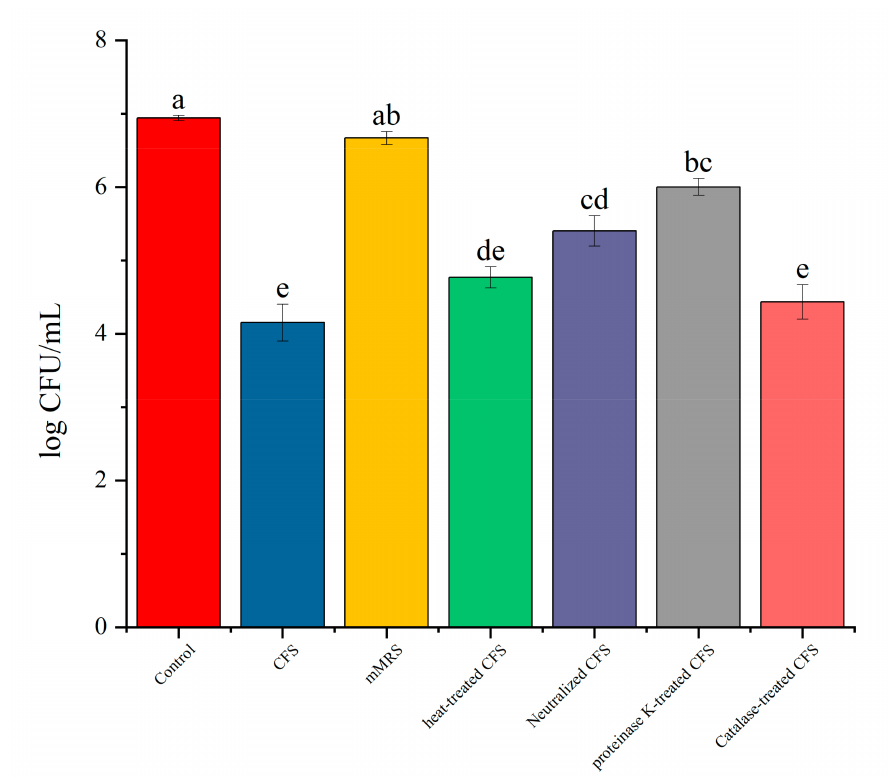
Figure 4. Effects of LN12 CFS with different treatments on the H. pylori 3192 biofilm. Heat-treated CFS: LN12 CFS 115 ◦ C heated for 20 min; neutralized CFS: LN12 CFS adjusted the pH to 6.5 with 1 M NaOH; proteinase K-treated CFS: LN12 CFS treated with 1 mg/mL proteinase K (final concentration) for 1 h at 37 ◦ C and inactivated by heating at 95 ◦ C for 1 min; catalase-treated CFS: LN12 CFS treated with 0.5 mg/mL catalase (final concentration) for 1 h at 37 ◦ C and inactivated by heating at 95 ◦ C for 30 min; mMRS: modified de Man Rogosa Sharpe broth; BB2 were the controls. The experimental data are represented by the mean ± standard deviation ( n = 3), and the groups marked with different superscript letters indicate statistically significant differences ( p <